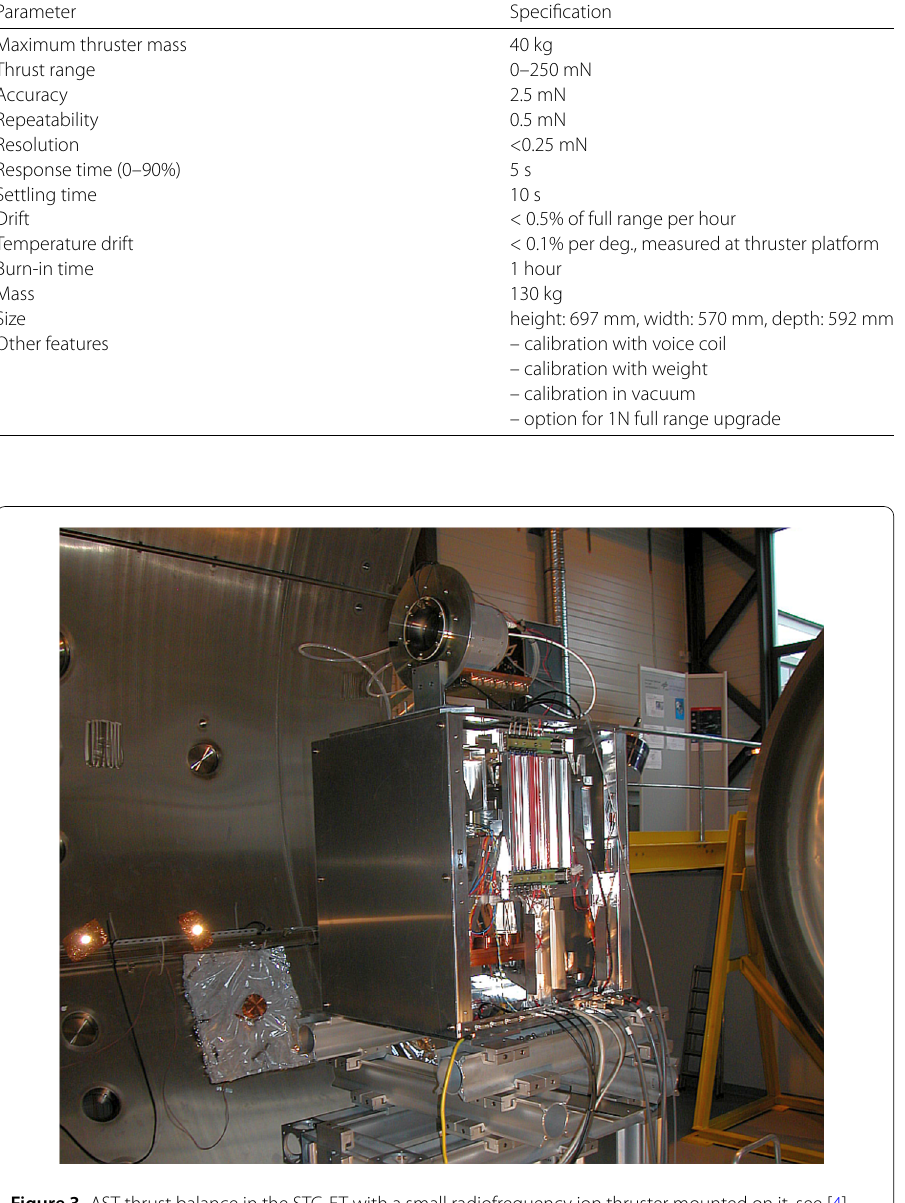
Figure 3 AST thrust balance in the STG-ET with a small radiofrequency ion thruster mounted on it, see